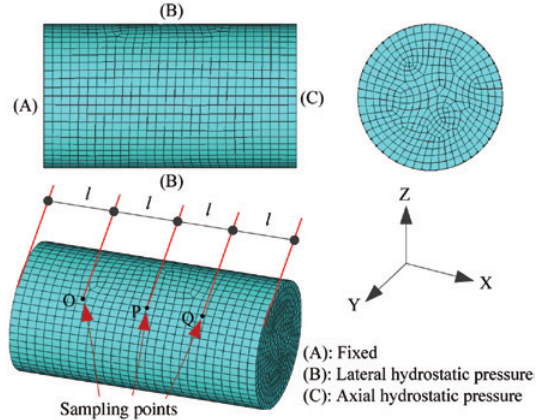
Figure 1: The finite element model.